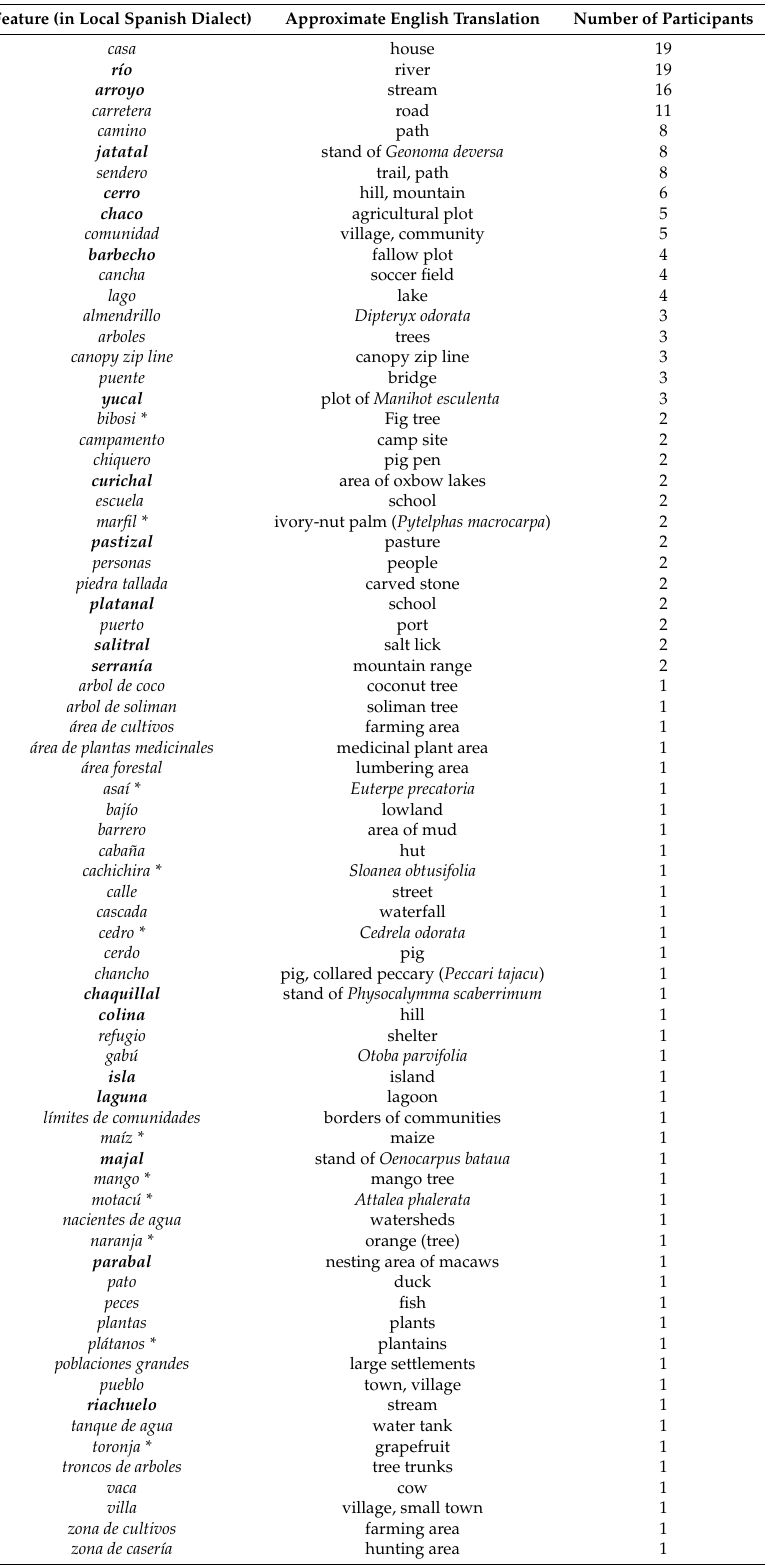
Table 1. Feature types drawn on sketch maps (categories shared with ethnoecological landscape categories represented in bold, plant names marked with * indicative of vegetation